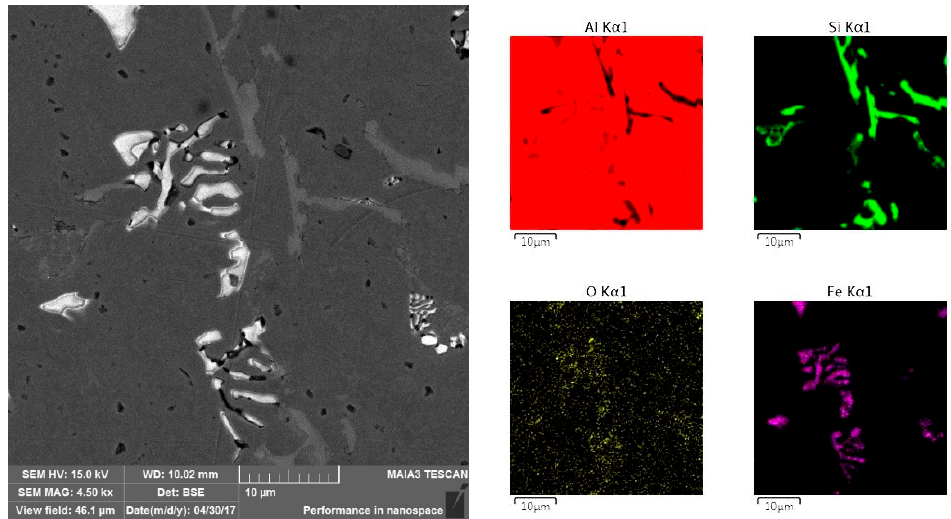
Figure 4. Scanning electron microscopy image of the Al 10 SiFe complex intermetallic compound and energy dispersive spectroscopy (EDS) mapping analysis of the image.